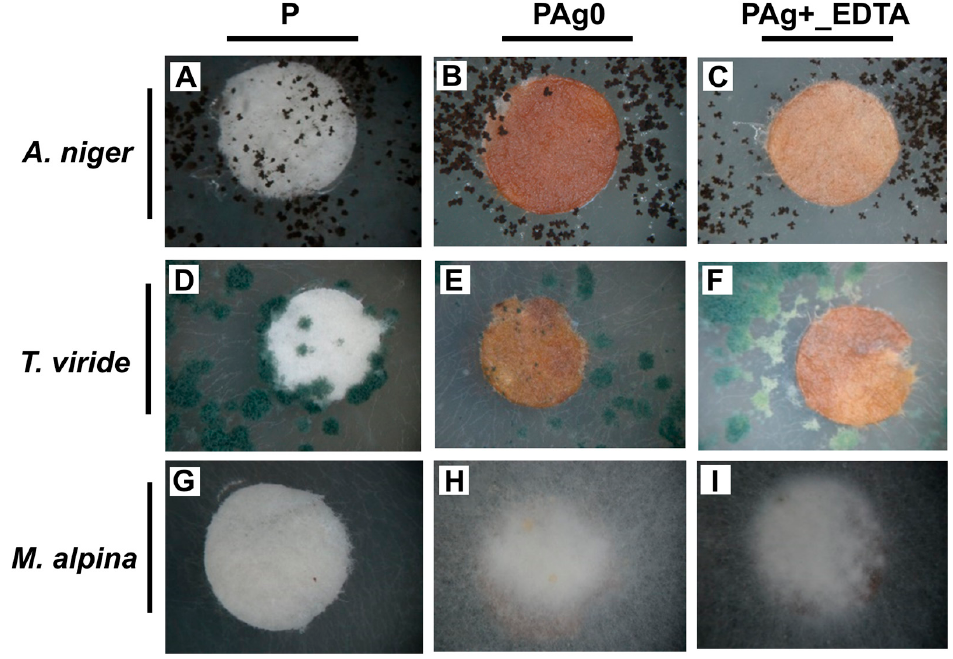
Figure 3. Examples of antifungal activity of silver ‐ exchanged zeolite PZAg+_EDTA ( C , F , I ); reference